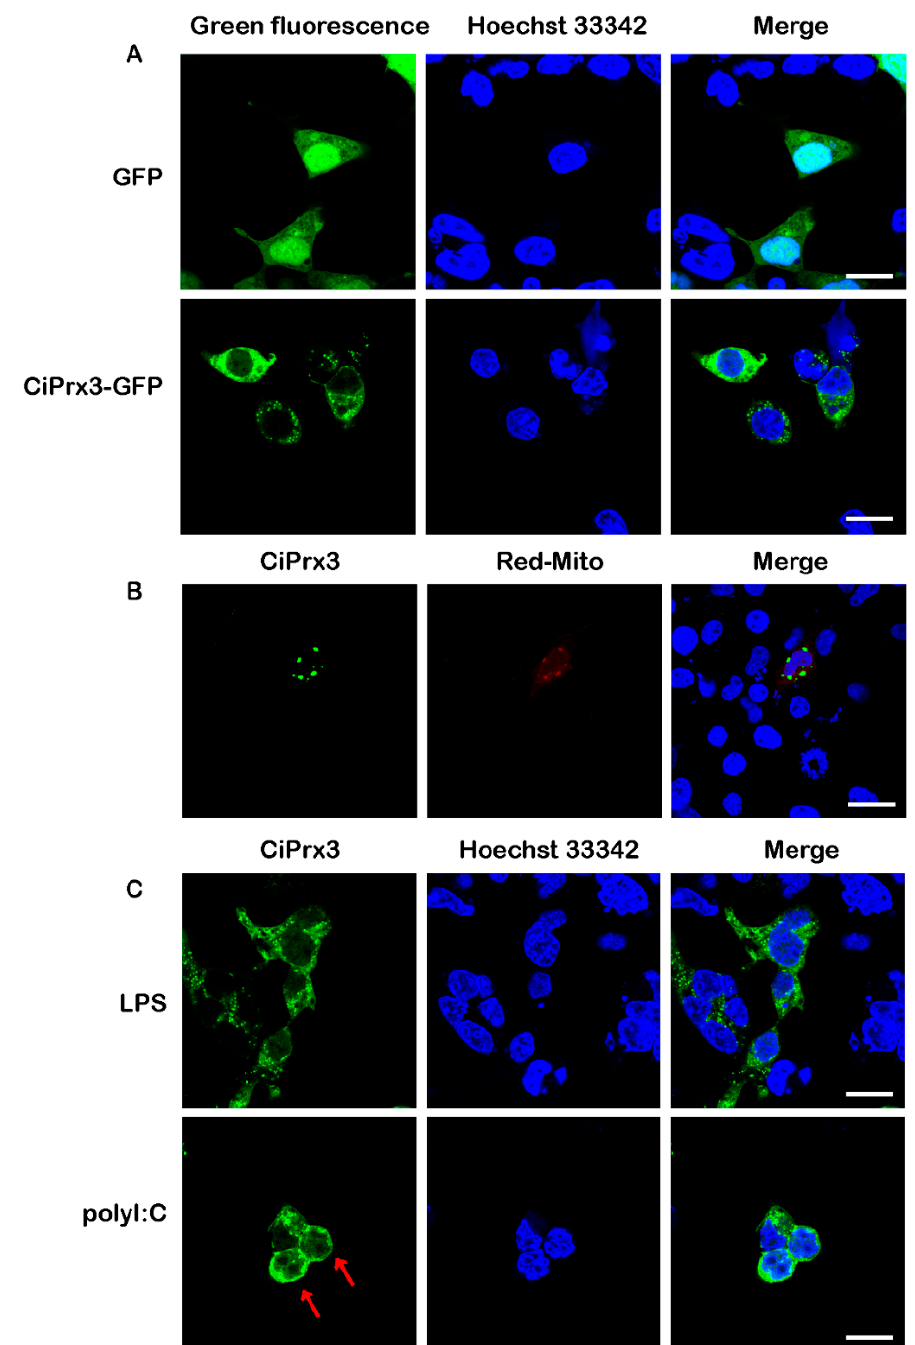
Figure 4. Subcellular localization of CiPrx3 in GCO cells. ( A ) Subcellular localization patterns of CiPrx3 protein in normal cells. ( B ) CiPrx3 -EGFP colocalized with mitochondria. ( C ) Subcellular localization patterns of CiPrx3 protein under PAMP stimulation. Red arrows indicate the nuclear translocation of the CiPrx3 fusion protein induced by poly (I:C) stimulation. Scale bar = 20 μ m.